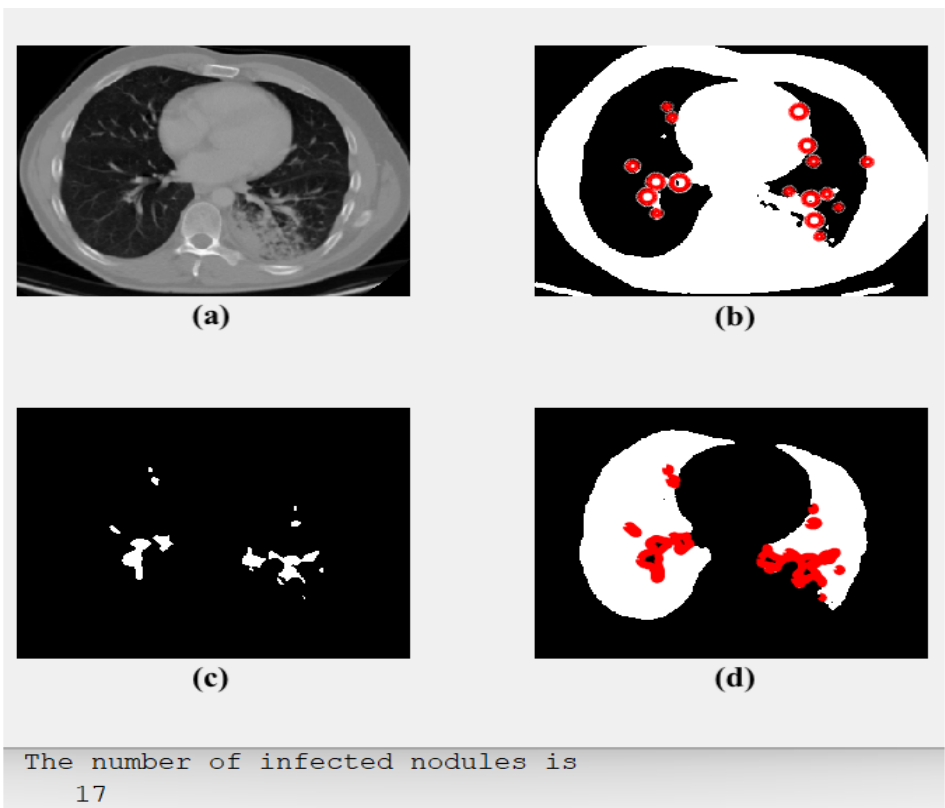
Figure 5. The results of Case 3: ( a ) an input, ( b ) segmented potential RoIs, ( c ) the outlined spots, and ( d ) type of detected tumor: SCC. Table 4. The evaluated performance metrics of VGG-19.